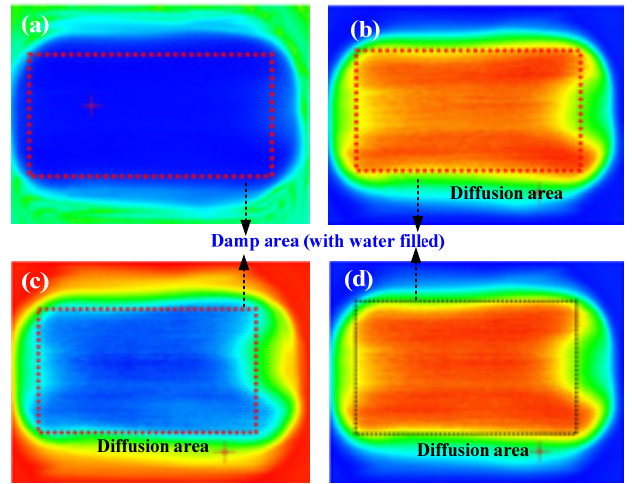
Figure 23. Terahertz images of the test sample under different imaging modes at 0.842 THz [73]. ( a ) Absorption spectrum imaging; ( b ) Maximum peak imaging; ( c ) Minimum peak imaging; ( d ) Peak- peak imaging.